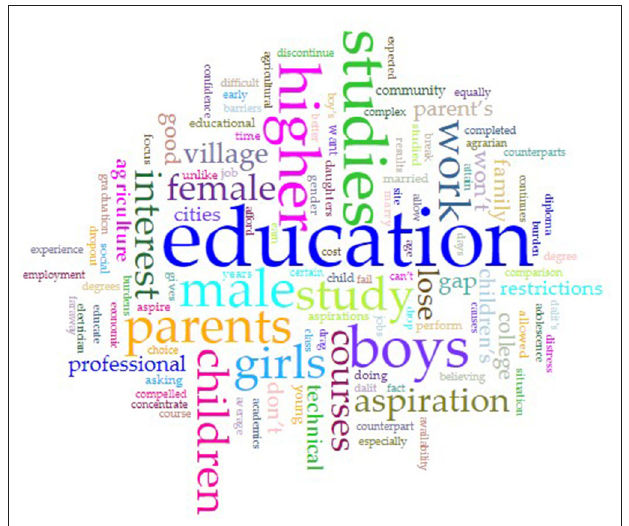
FIGURE 5 | Aspirations and dreams of parents toward their